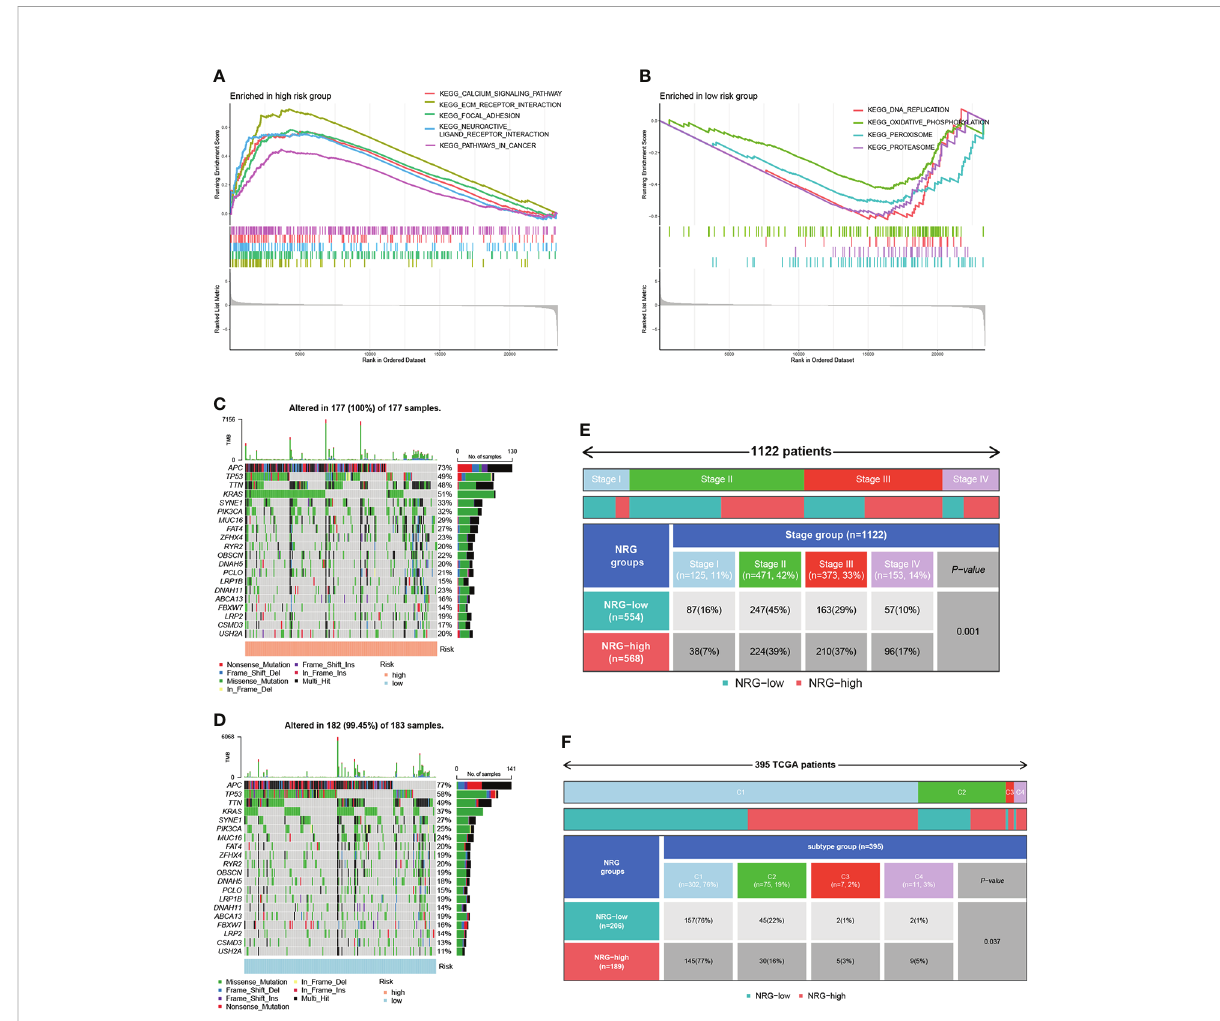
FIGURE 7 GSEA analysis, mutation, and clinical-related analysis of the signature. GSEA analysis showing pathways enriched in the high-risk group (A) and low-risk group (B) . The distribution of somatic mutations in the high-risk group (C) and low-risk group (D) . (E) The correlation between risk scores and stage. (F) The correlation between risk scores and immune